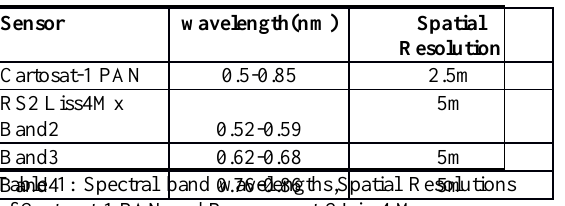
Table 1: Spectral band wavelengths,Spatial Resolutions of Cartosat-1 PAN and Resroucesat-2 Liss4